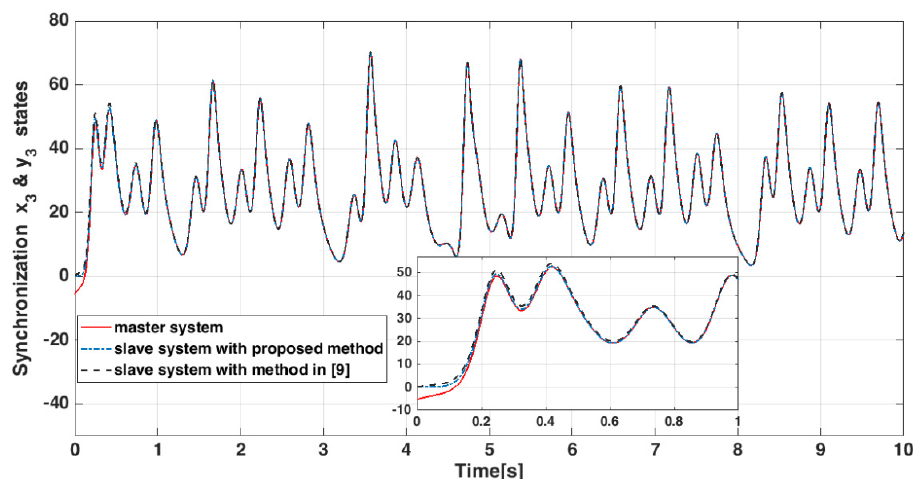
Figure 9. Time responses of states x 2 and y 2 .